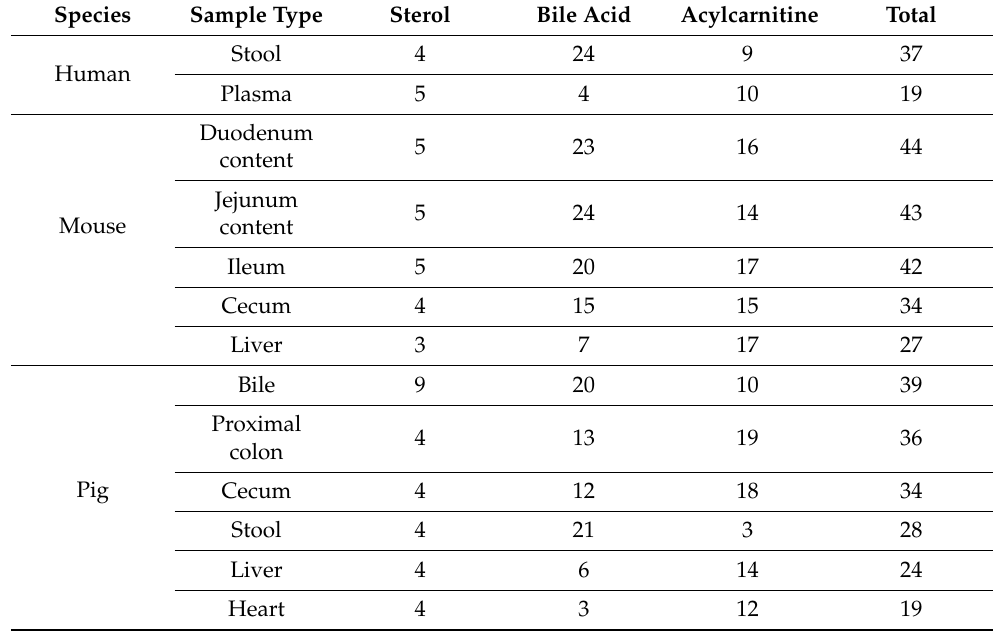
Table 1. Total number of sterol, bile acid, and acylcarnitine metabolites identified in biological